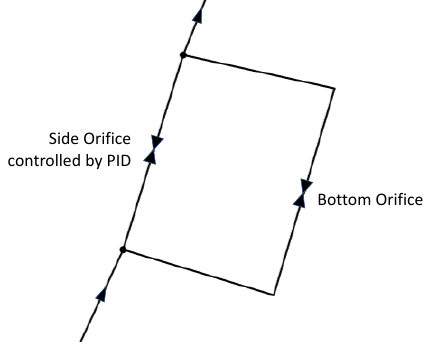
Figure 8. SWMM representation of the two orifices “side” and “bottom”.